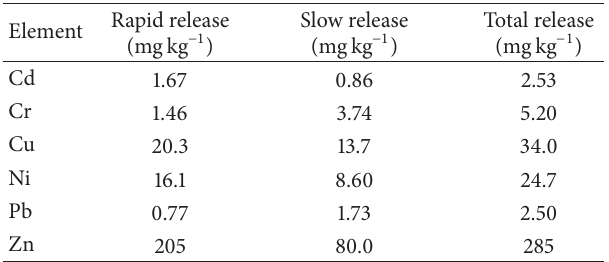
Table11:Amountsofmetalsthatwereextractablefromthebiosolid- Table 12: The slope † of metal extracted from the